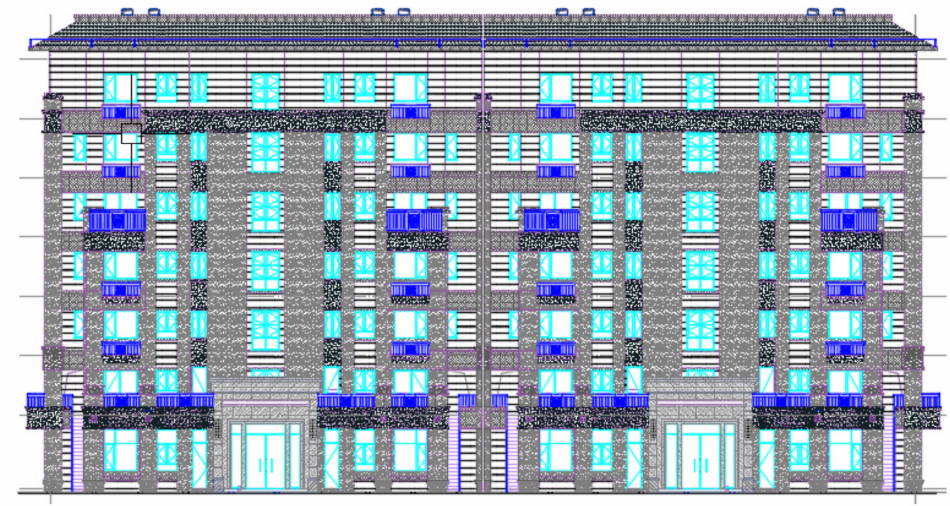
Figure 5. The facade update (view